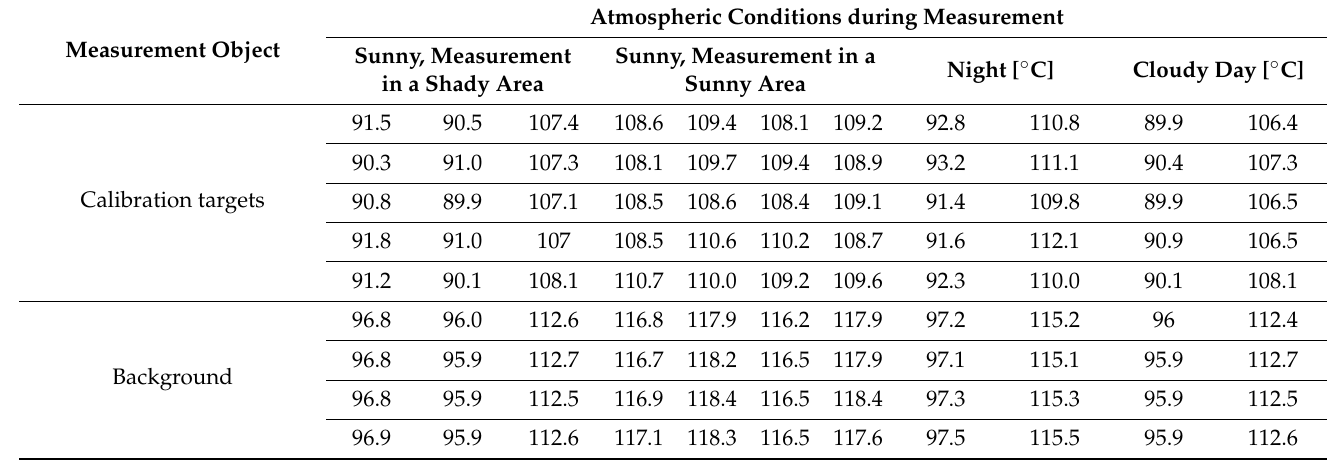
Table A2. Influence of manual and automated enhancing on geometric calibration accuracy.